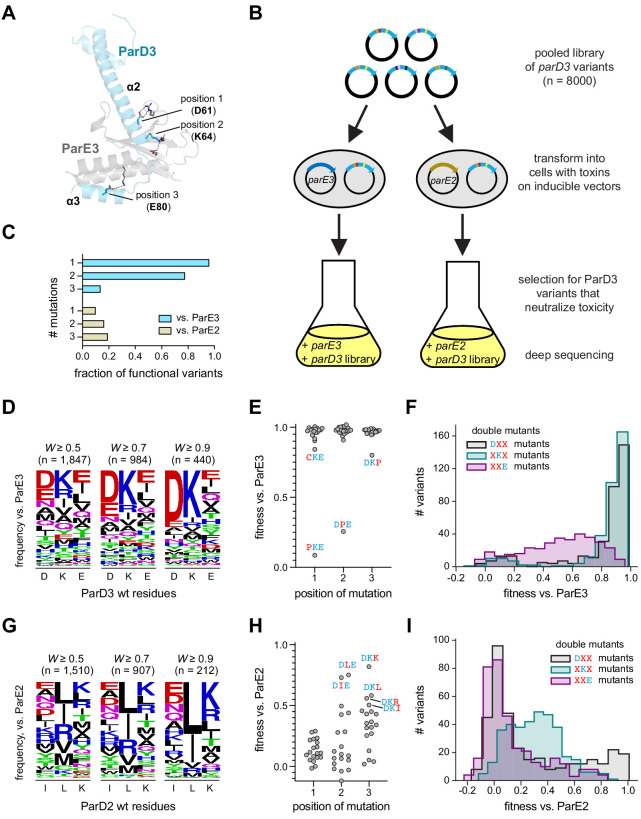
Mapping variant fitness via a combinatorially complete library.(A) Residues mutated in the saturation mutagenesis library, mapped onto the ParD3-ParE3 crystal structure (PDB: 5CEG). Salt bridges between ParD3 library positions and ParE3 are indicated. Note that ParD3-ParE3 forms a symmetric tetramer with two chains of each protein; for simplicity, only a single chain of each is shown. (B) Schematic of the ParD3 library experiment. (C) Fraction of single, double, and triple mutants that neutralize ParE3 or ParE2 (W ≥ 0.5). (D) Frequency of amino acids at each position for variants that neutralize ParE3, summarized as a sequence logo, as the fitness thresholds indicated. (E–F) Fitness of all single (E) and double (F) mutants against ParE3. (G–I) Same as in (D)-(F), but for ParE2.